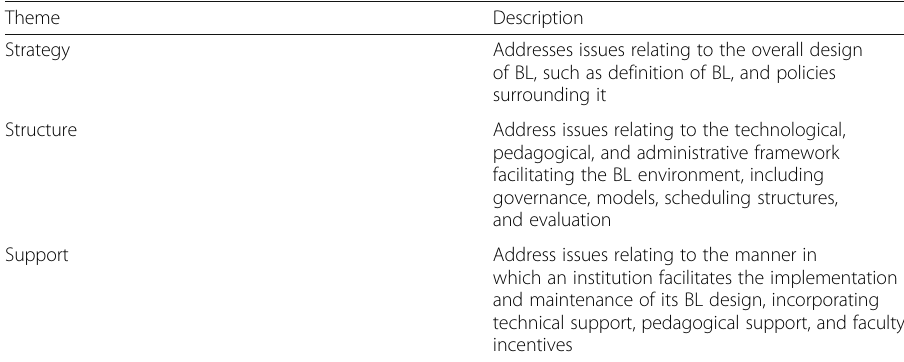
Table 6 Dimensions to consider for a bLearning implementation. Source: (Porter et al., 2014, p.